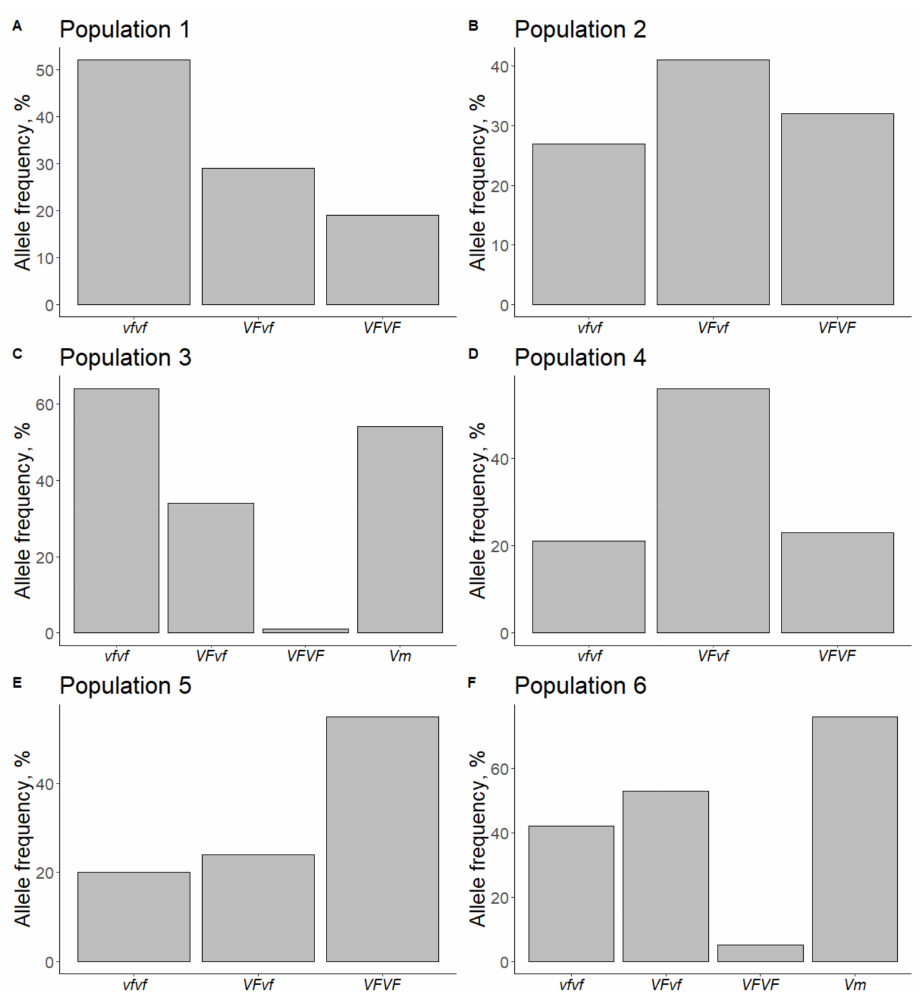
Figure 4. The frequency of identified alleles for the apple scab resistance Rvi5 and Rvi6 genes. Description of populations by apple scab resistance gene occurrence in parent plants: ( A )— Rvi6 × susceptible cultivar, ( B )— Rvi6 × susceptible cultivar, ( C )— Rvi6 × Rvi5 , ( D )— Rvi6 × Rvi6 , ( E )— Rvi6 × Rvi6 , ( F )— Rvi6 × Rvi5 (population designations are given in Table